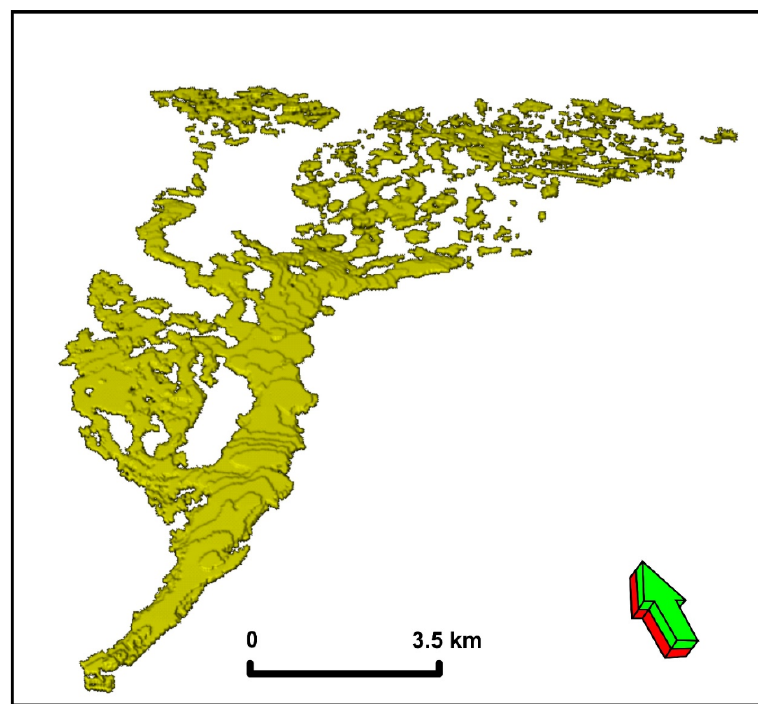
Figure 4. ( a ) Digital elevation model with contour lines (0.25 m interval) for R1, R2 and R3. ( b ) In ‐ terpretation of terrace risers and reconstruction of the ~7 m offset. ( c ) Reconstruction of the ~30 m offset [113].